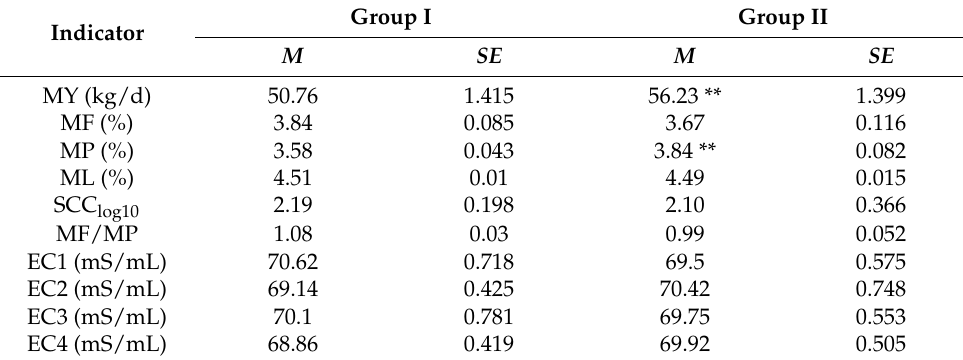
Table 2. Differences between milk parameters according to NEFA